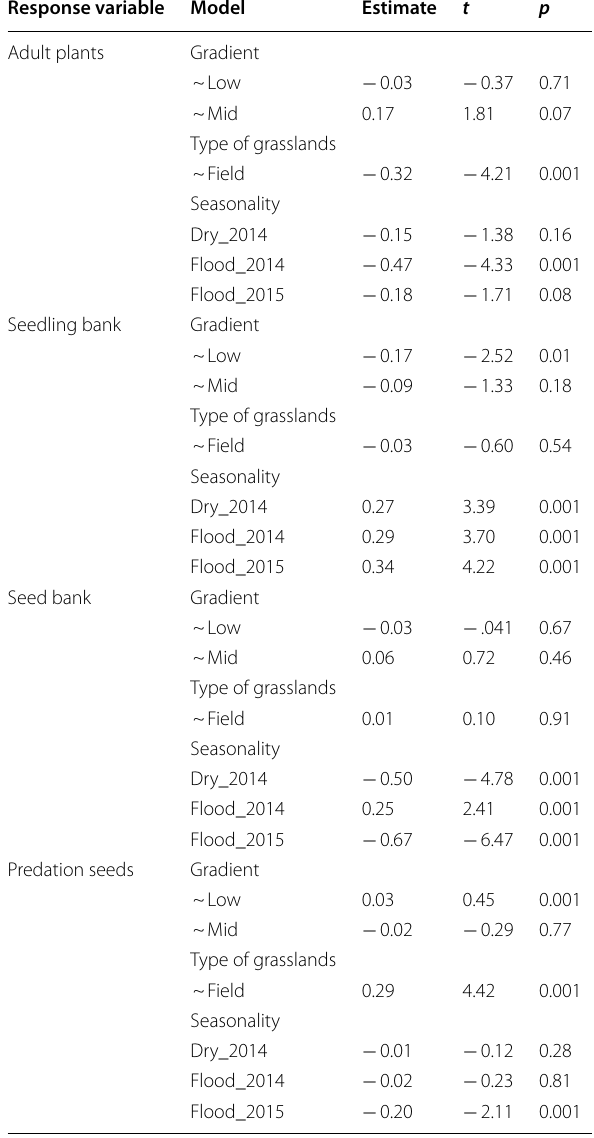
Table 1 Coefficients of linear mixed effect models to explain the main effects of topographical conditions (included three levels, low, mid, and high position), seasonal floods (have two levels, post-flood and post-dry) and, type of grasslands (have two levels, native and cultivated) on growth stages of population (adults and seedling) and population-related ecological processes (seed bank and predation), Pantanal